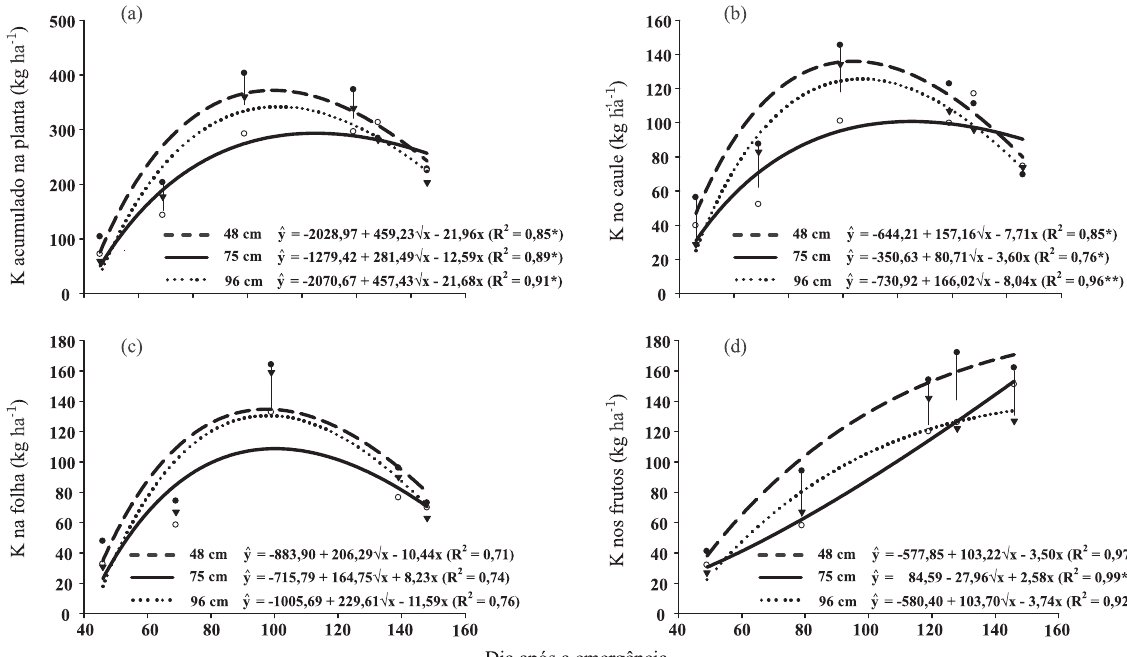
figura 4. potássio acumulado na planta (a), no caule (b), nas folhas (c) e nos frutos (d) do algodoeiro cul- tivado nos espaçamentos de 48 ( ), 75 ( ) e 96 cm ( ). A barra vertical representa a diferença mínima significativa (dms p <